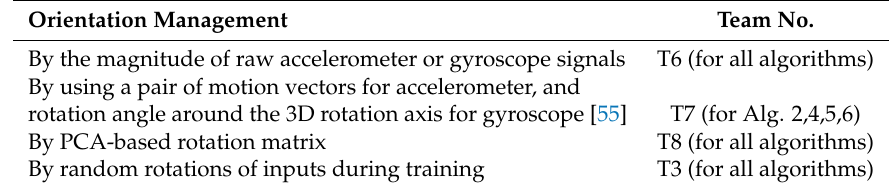
Table 3. Approaches to sensor-orientation invariance, managed by the